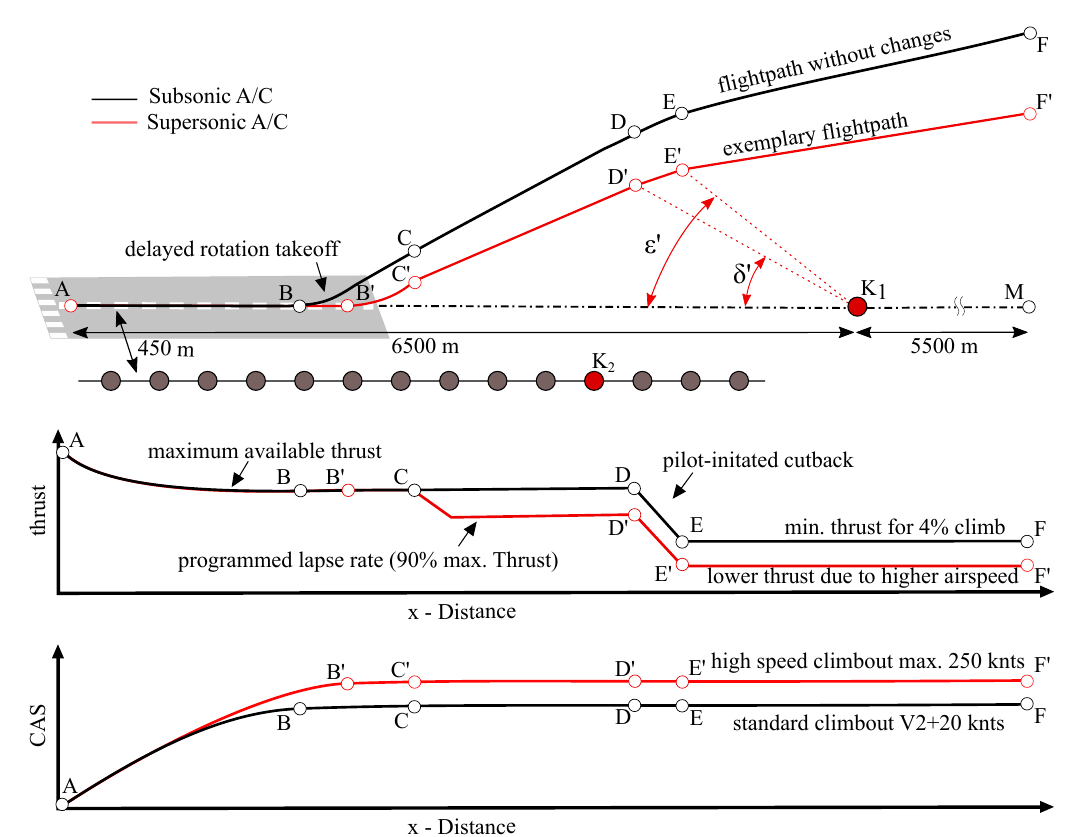
Figure 9. Take-Off reference flight path profile of subsonic and supersonic aircraft for noise certification ( top ). Changes of thrust ( middle ) and calibrated airspeed ( bottom ) profiles for discussed new supersonic noise certification regulations due to high-speed climbout and Programmed Lapse